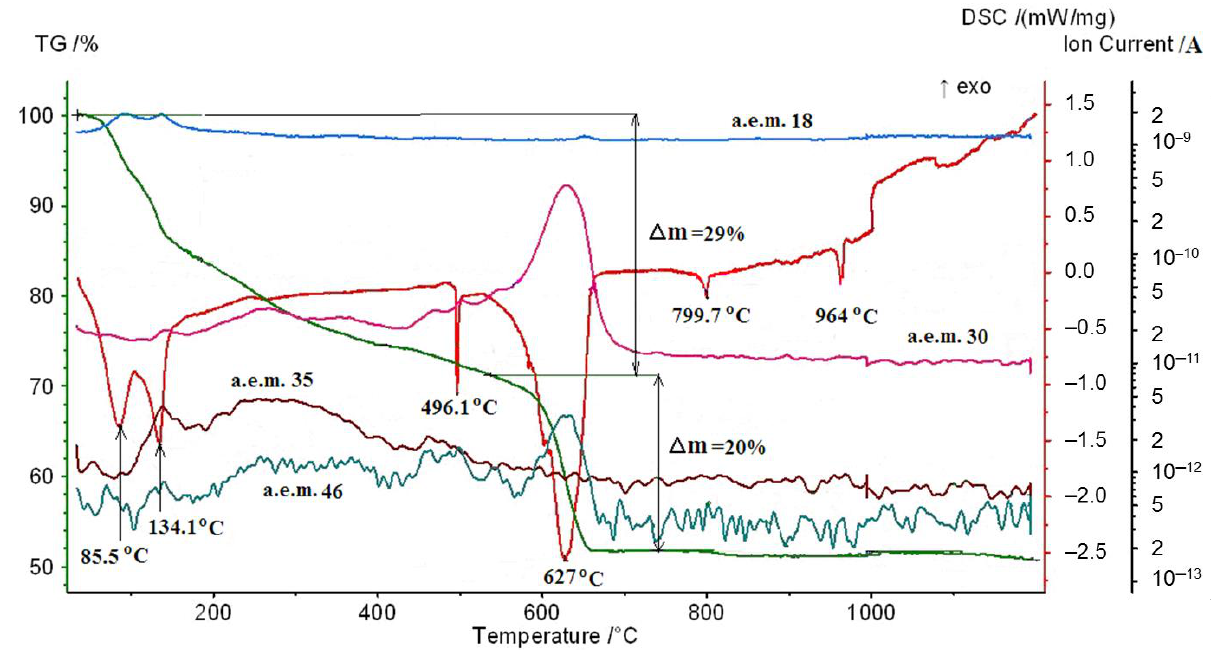
Figure 1. TGA/DSC and ion currents for the sediment powder obtained by drying of the film-forming solution.